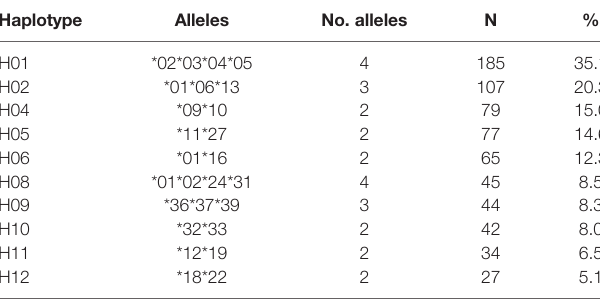
TABLE 1 | Allelic composition of the ten haplotypes ( Haplotype , H01, H02 etc.) that occurred in >5% of the studied individuals. Haplotype Alleles No.